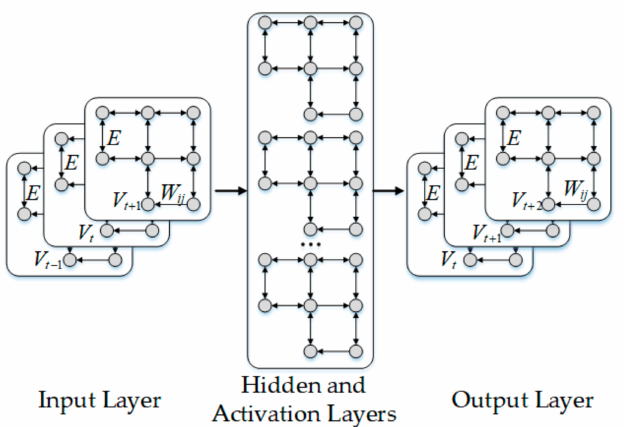
Figure 7. Graph convolutional